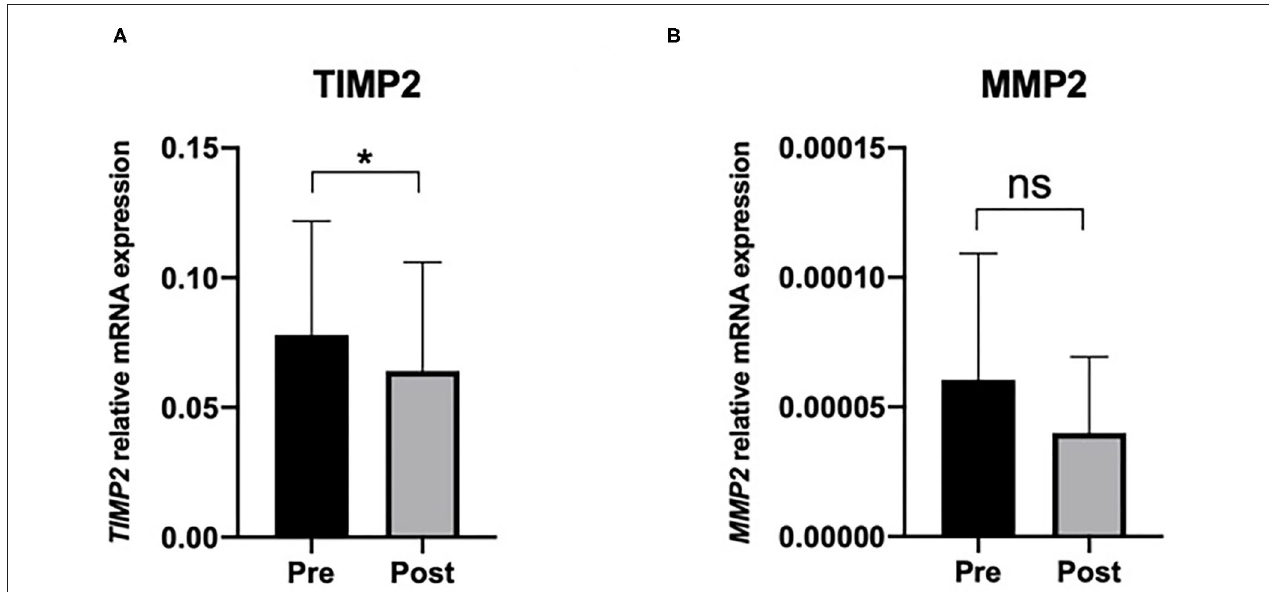
FIGURE 1 | Peripheral blood mononuclear cells expression. Of (A) Tissue inhibitor of metalloproteinase 2 ( TIMP2 ) and (B) Matrix metalloproteinase 2 ( MMP2 ), relative to GAPDH/P-actin. Values are mean and standard deviation. *Wilcoxon matched-pairs signed-rank test p < 0.05. Pre, pre-operative; post, post-operative; ns, non-significant.